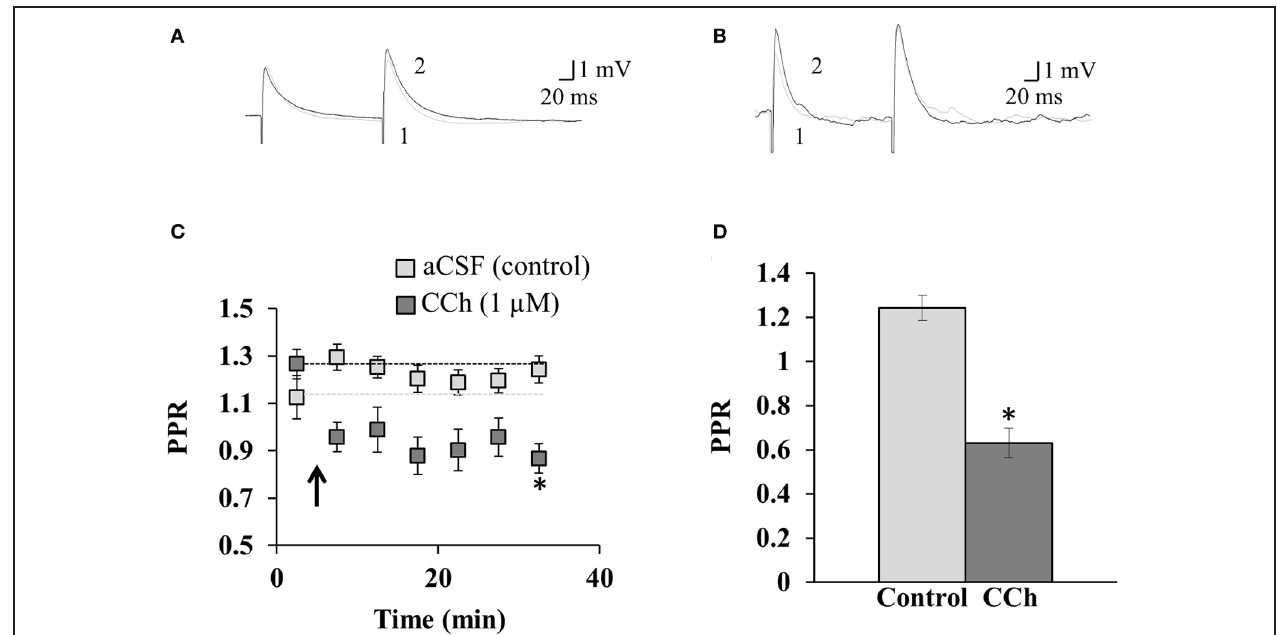
arrow; coincident pre- and post-synaptic activity at 5Hz for 1min), for neurons perfused with aCSF or CCh. ∗ Indicates significance ( p = 0 . 002). Dashed lines indicate normalized pre-induction amplitude for each condition. (D) Summary of the PPR ratio in the last 5min of the recording for neurons perfused with aCSF ( n = 9) or CCh ( n = 4). ∗ Indicates significance ( p < 0 . 001). Error bars represent ± one